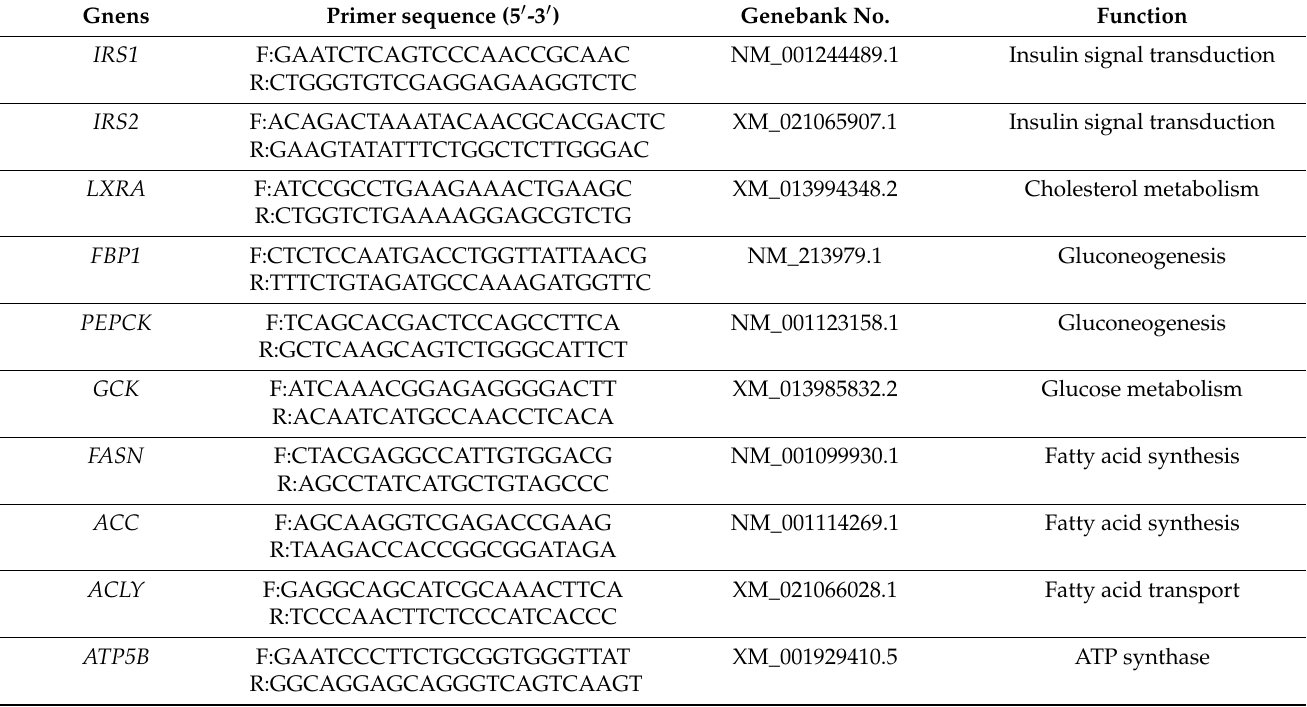
Table 2. Primers and annealing temperature for relative real-time